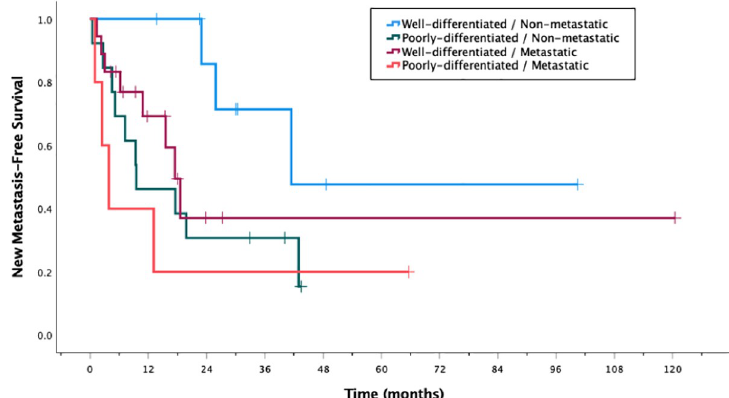
Fig 1. Kaplan-Meier plot of new metastasis-free survival after radiation, as grouped by differentiation and stage.